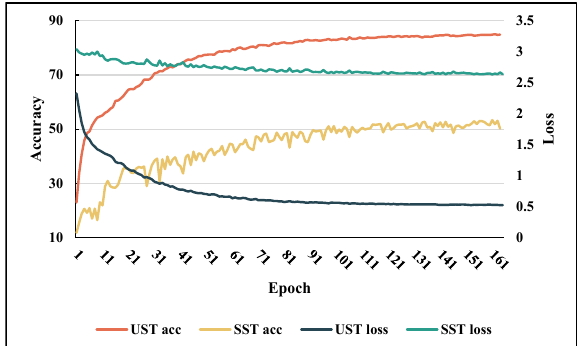
Figure 15. On TDSs-22, the tendencies of the losses and the accuracies of UST and SST.